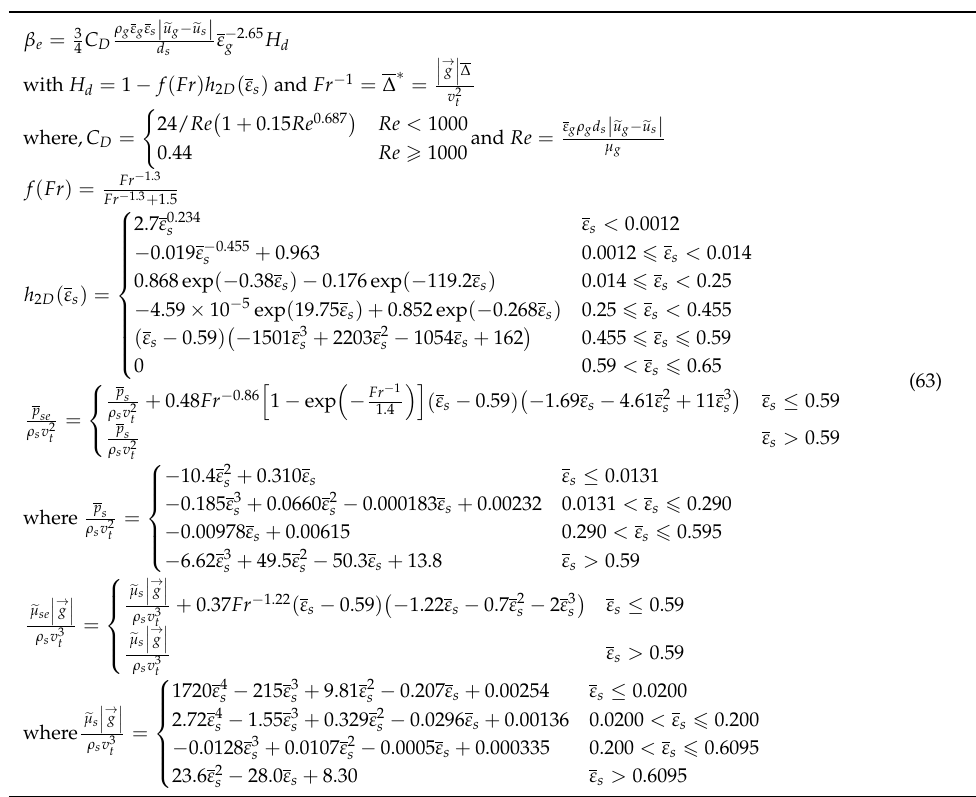
Table 14. The representative filtered drag model by Igci et al.